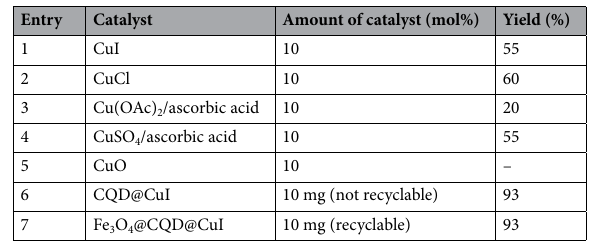
Table 3. Evaluation of various catalyst for the synthesis of triazole-dihydropyrano-pyran in click reaction with Fe